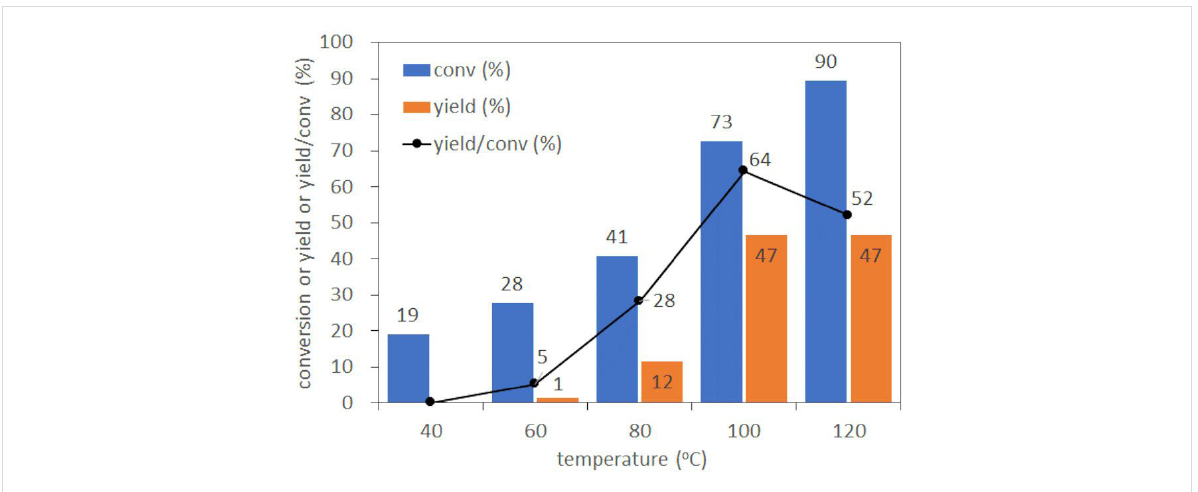
Figure 3: Investigation of reaction temperature in flow epoxidation of cyclohexene at residence time of 0.35